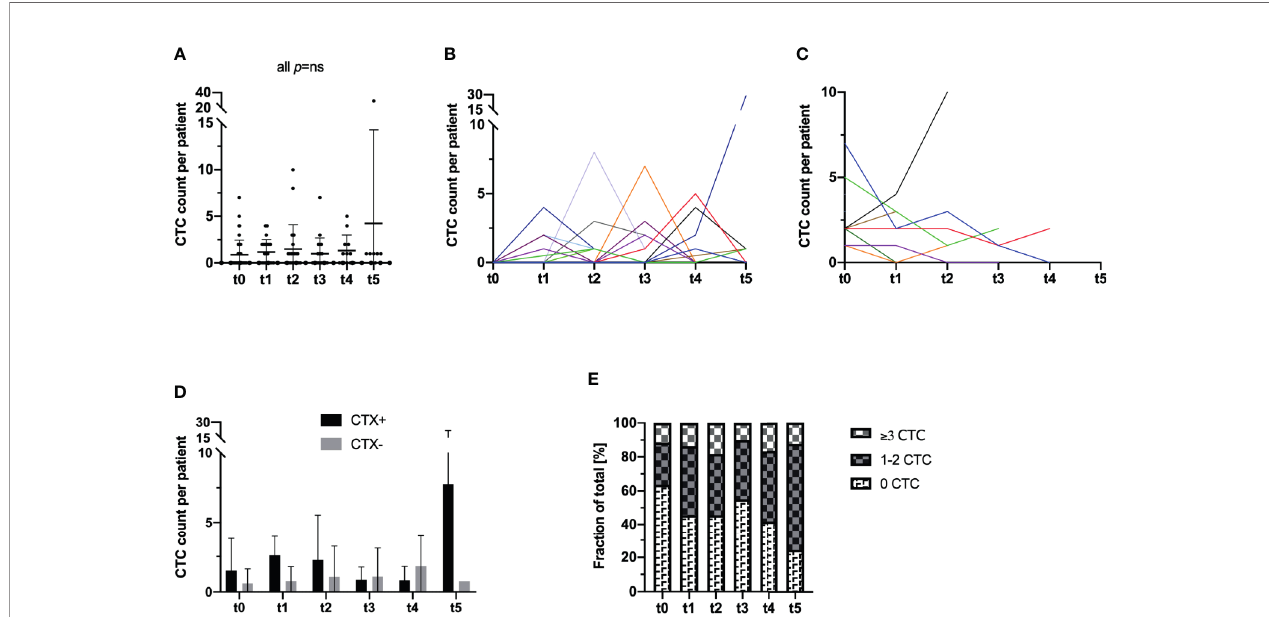
FIGURE 2 | Longitudinal analysis of blood samples of 44 CRC patients for the incidence and enumeration of CTC by a semi-automated microscopical approach with NYONE ® . (A) In the study cohort as a whole, no statistically signi fi cant deviations in terms of an in- or decrease of the CTC count compared to t0 could be observed. The bar represents the mean count of CTC. (B, C) The individual patient with its longitudinal CTC quanti fi cation data is displayed by each line (each color represents one patient). (B) All patients that pre-operatively (t0) had no detectable CTC were analyzed in this subset. At t1, there was a statistically signi fi cant (p=0.023) increase in the CTC quantity. Throughout the further visits, no signi fi cant deviation from the initial CTC quantity (t0) was observed. (C) All patients with detectable CTC at t0 were sub-grouped for this analysis. There was no statistical signi fi cance for deviations over the study period from the initial CTC count. (D) Patients were strati fi ed and subdivided according to their necessity of adjuvant chemotherapeutic treatment (CTX+). Patients that did not require adjuvant treatment were grouped in the follow-up subset (CTX-). (E) Patients were strati fi ed and grouped according to the patients´ individual quantity of CTC: No CTC, 1-2 CTC (intermediate), ≥ 3 CTC (high). Analyzing the data as fractions of a whole, throughout the study a signi fi cant increase of patients with intermediate or high CTC counts was